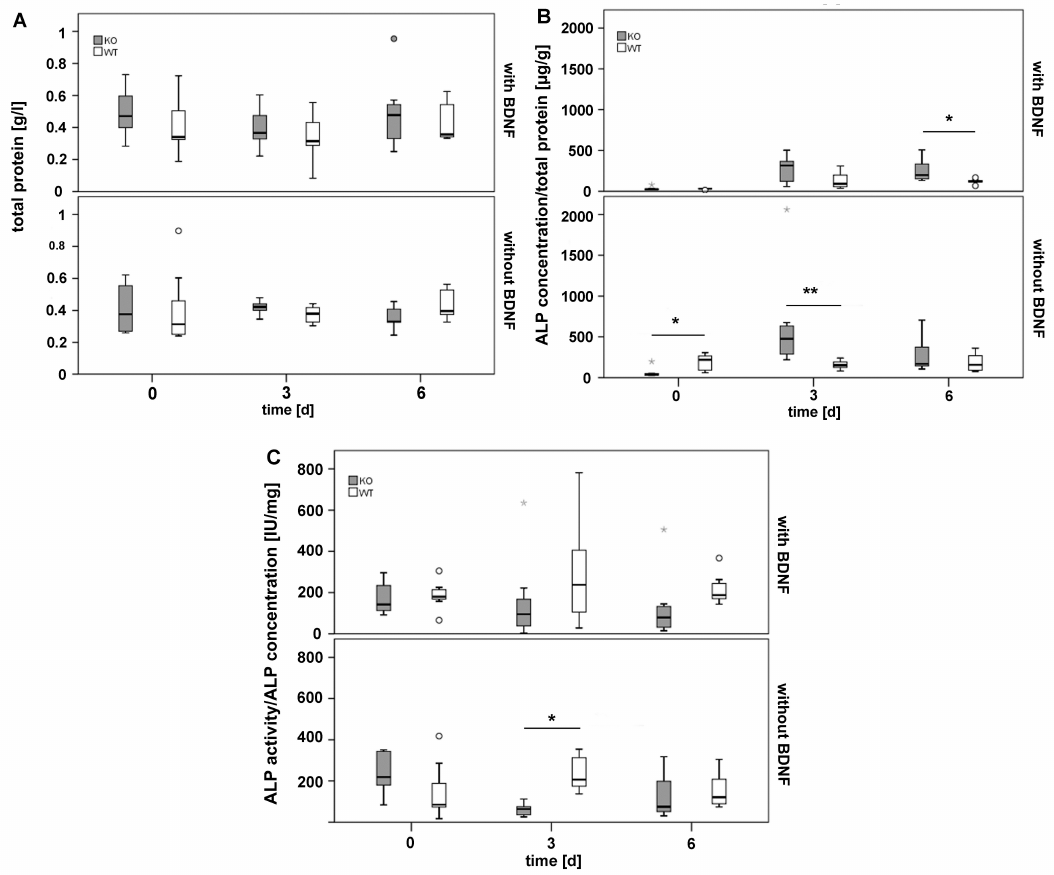
Figure 7. Total protein ( A ) ALP concentration ( B ) and ALP activity ( C ) in callus tissue of M3 mAChR KO and WT mice. The grey and white circles indicate outliers. Extreme outliers are represented by a grey star. The * and ** illustrate statistically significant differences with a likelihood of p ≤ 0.05 and 0.01,